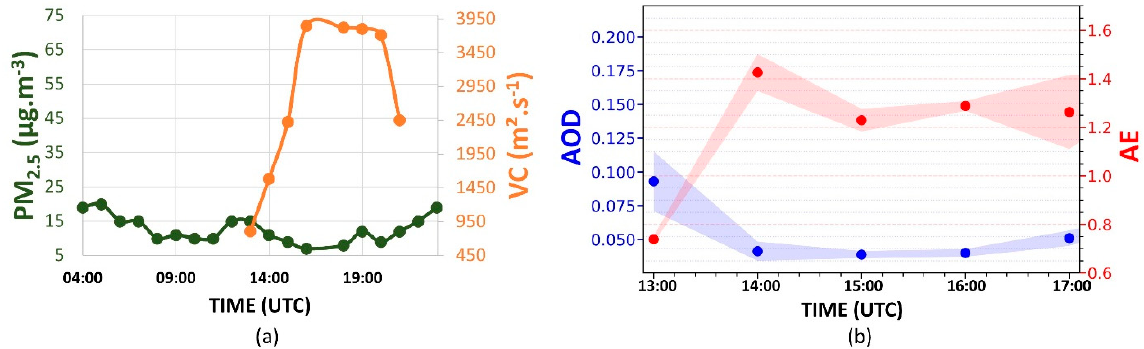
Figure 4. ( a ) Daily cycles of PM 2.5 concentration (green dots) and ventilation coefficient (VC, orange dots); ( b ) aerosol optical depth (AOD) at 500 nm (blue points) and Ångström exponent (AE, 440/675) (red points) hourly averages variation from 13:00 UTC to 17:00 UTC, on 22 July 2019. The blue and red shadows represent the AOD and AE standard deviation, respectively. The Aerosol Robotic Network (AERONET) data level is 1.5 for AOD and AE.